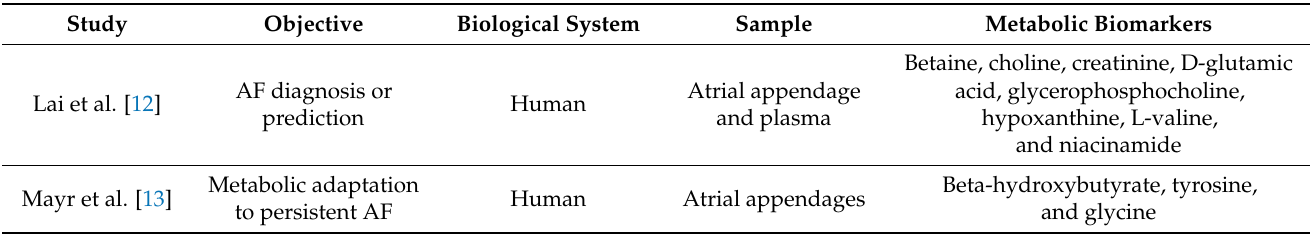
Table 1. Proposed metabolic biomarkers for AF in human patients and animal